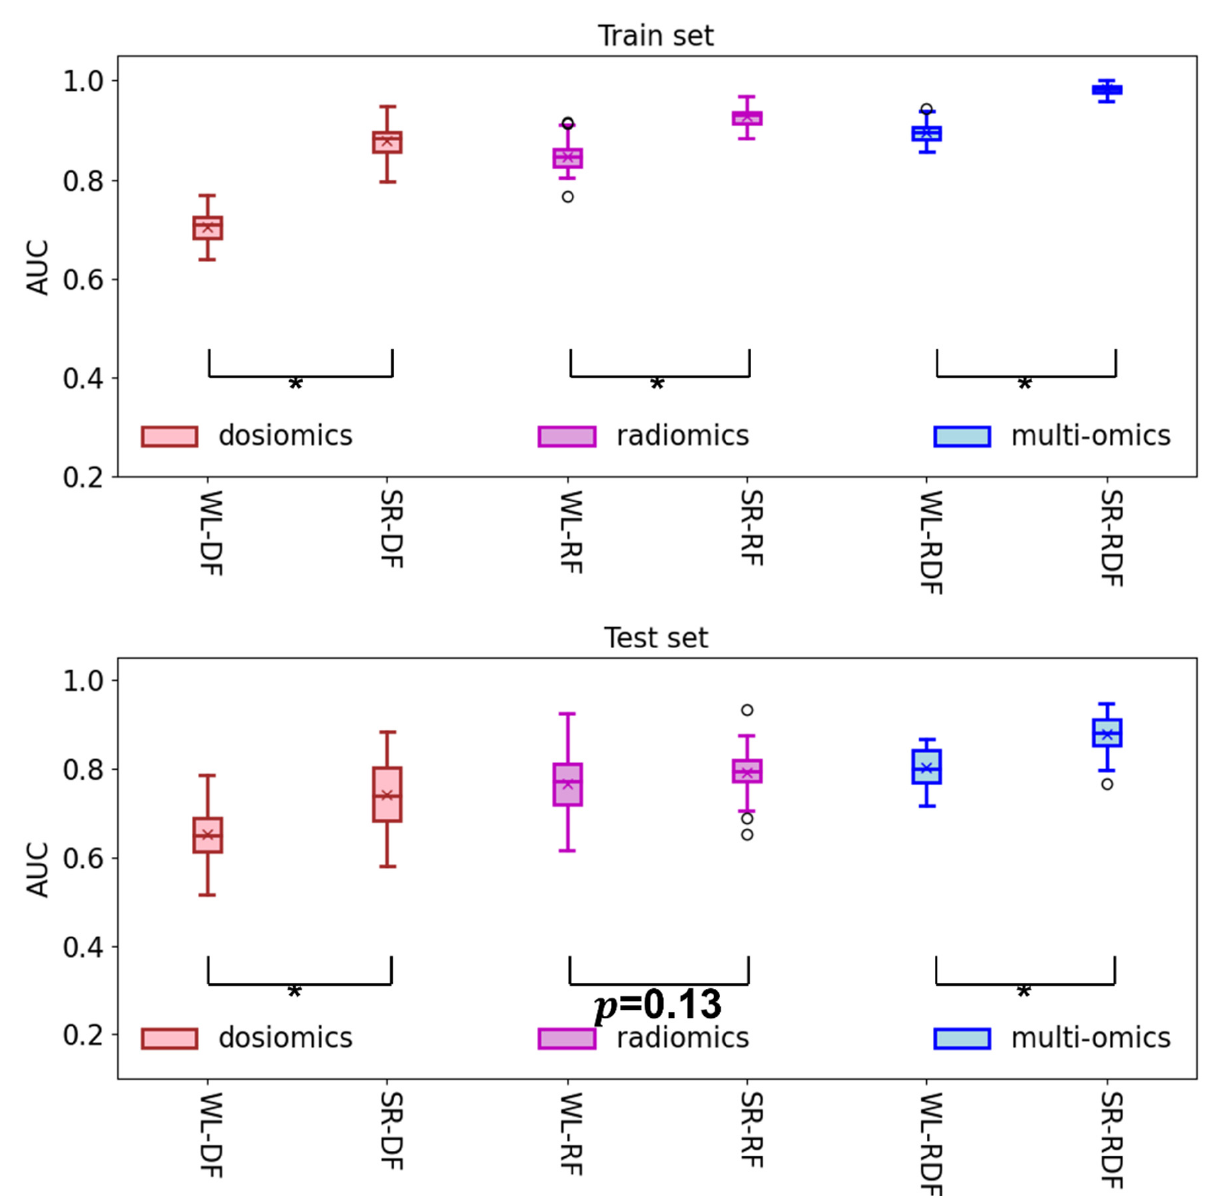
Figure 4. The model performance comparison between the models using subregion features and the whole lung features, i.e., SR-DF vs. WL-DF, SR-RF vs. WL-RF, and SR-RDF vs. WL-RDF, in the train and test AUCs. * p < 0.001.